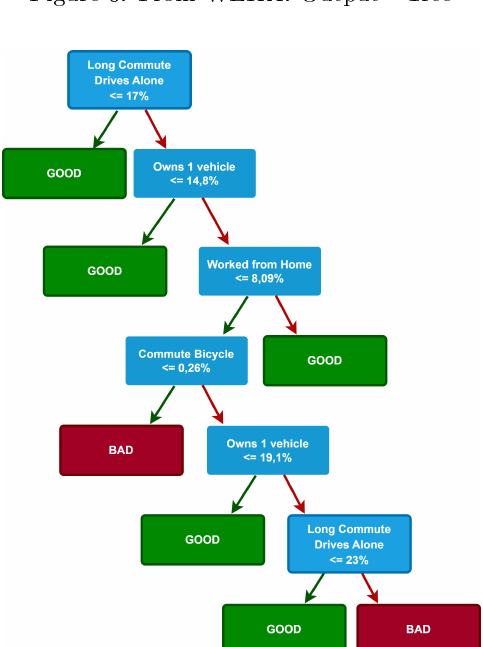
Figure 6: From WEKA: Output - Tree